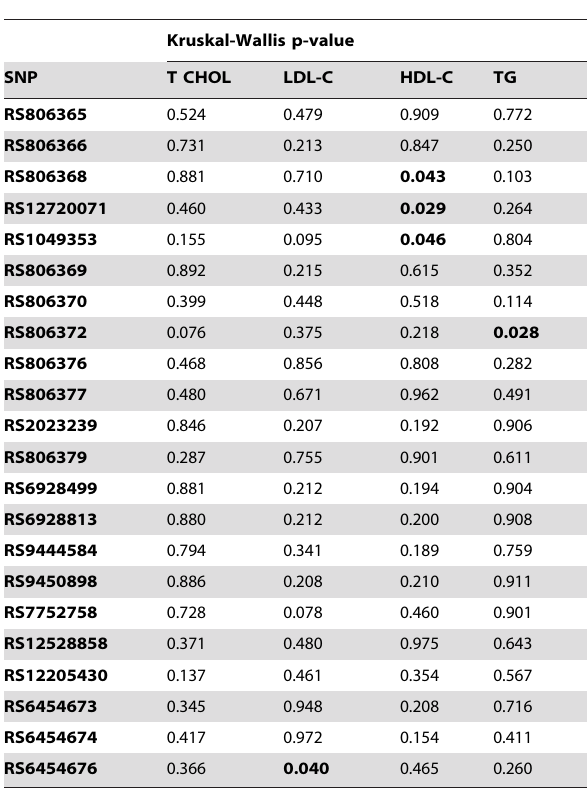
Table 5. Association between modeled lipid trait and single SNPs, over the same extended region of interest shown in Table 4 (Kruskal-Wallis p-values are